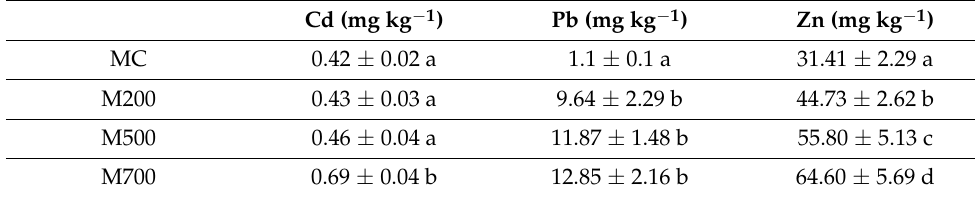
Table 2. Trace element (T.E.) concentrations in the leaves of Mis-B cultivar cultivated in soils with gradient T.E. concentrations (MC, M200, M500, M700). Values are presented as mean ± SE. Different letters refer to significant differences between plants (Tukey HSD test, n = 6, p ≤ 0.05).